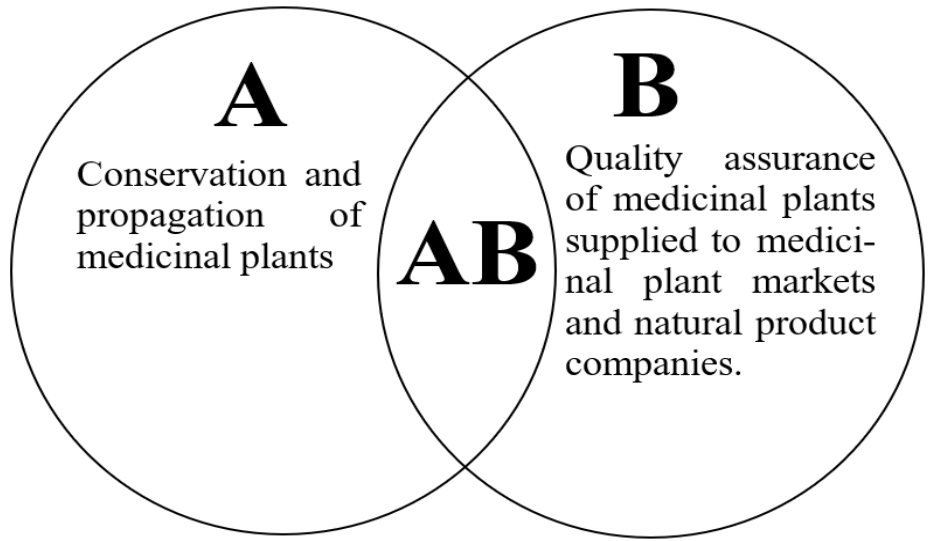
Figure 4. Conservation, propagation, and quality assurance as determining factors of the function ‐ ality of the traditional medicine